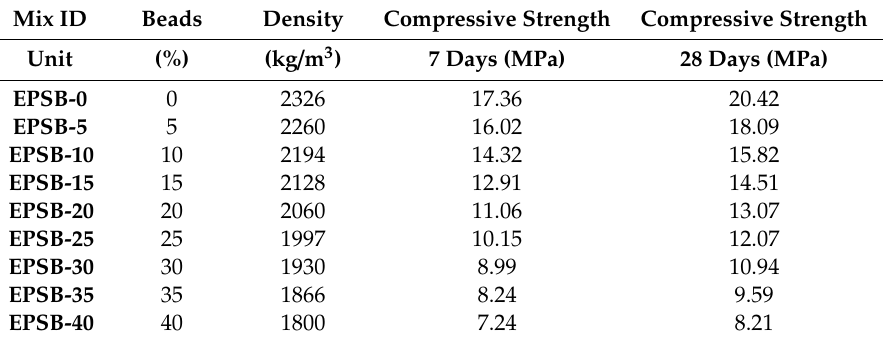
Table 7. Destructive compressive strength